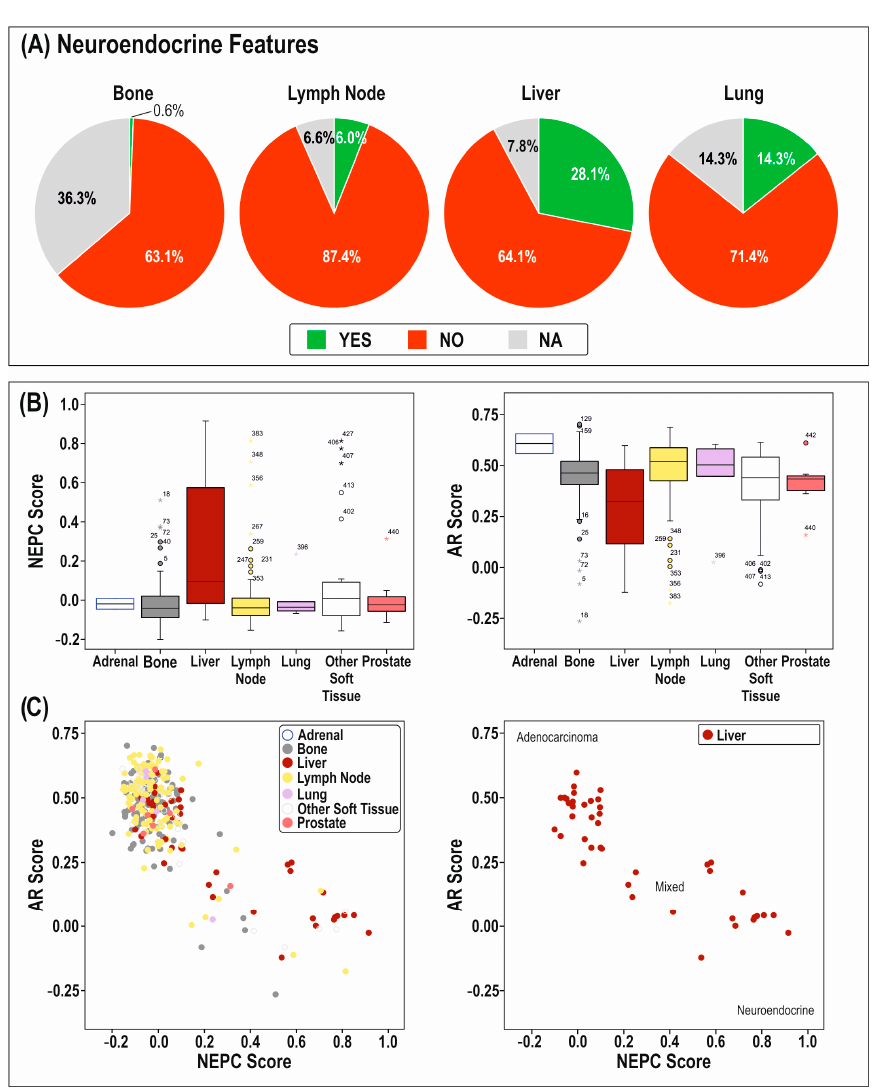
Figure 2. Characteristics of prostate cancer cells in the liver. A summary of data from Stand Up to Cancer (SU2C) database showing the cellular characteristics of prostate cancer cells that have metastasized to the bone (n = 160), lymph node (n = 167), liver (n = 64), and lung (n = 7). ( A ) The per- centage of metastatic tumors with pathologist defined neuroendocrine features. Green = metastases with neuroendocrine features, red = no neuroendocrine features, and grey = no characterization available. ( B ) Analysis of (i) neuroendocrine prostate cancer (NEPC) gene scores and (ii) androgen receptor (AR) activity gene scores in different metastatic sites. ( C ) Comparison of NEPC (horizontal) and AR (vertical) gene scores in (i) different metastatic sites, and (ii) the liver alone. Analyzed using publicly available data [61].